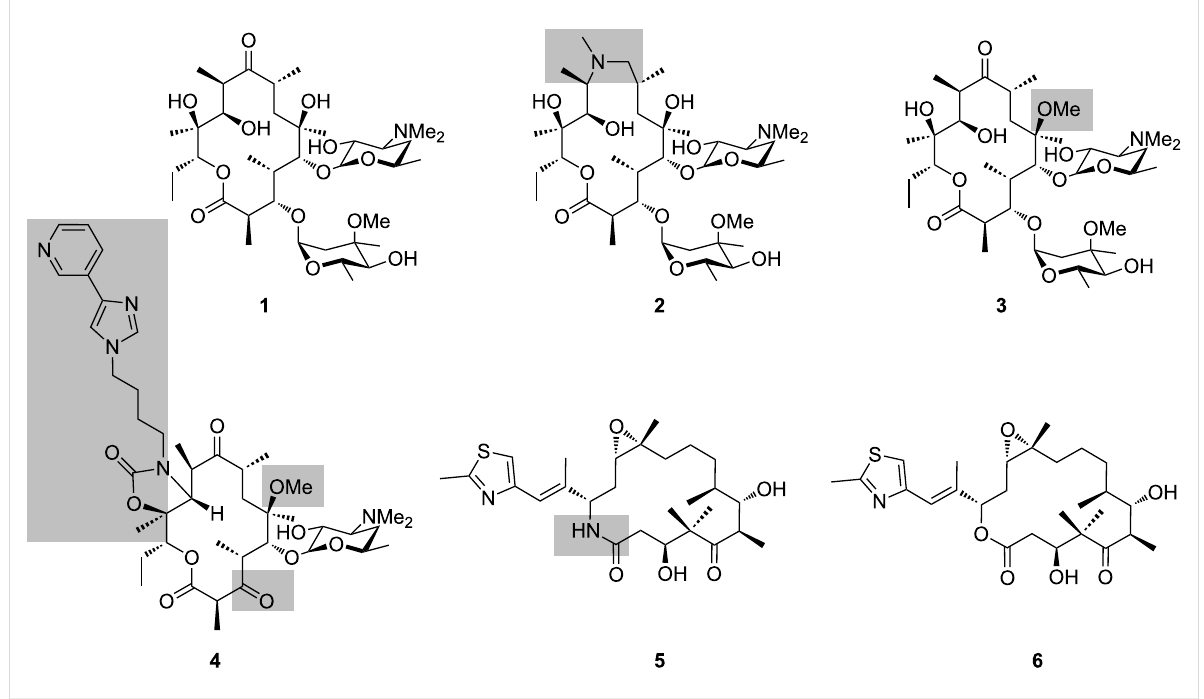
Figure 1: Structures of clinically-relevant polyketides: erythromycin A ( 1 ), azithromycin ( 2 ), clarithromycin ( 3 ), telithromycin ( 4 ), and ixabepilone ( 5 ) (a semi-synthetic derivative of epothilone B ( 6 )). The structural variations relative to the parent compounds 1 and 6 are indicated by the grey boxes.